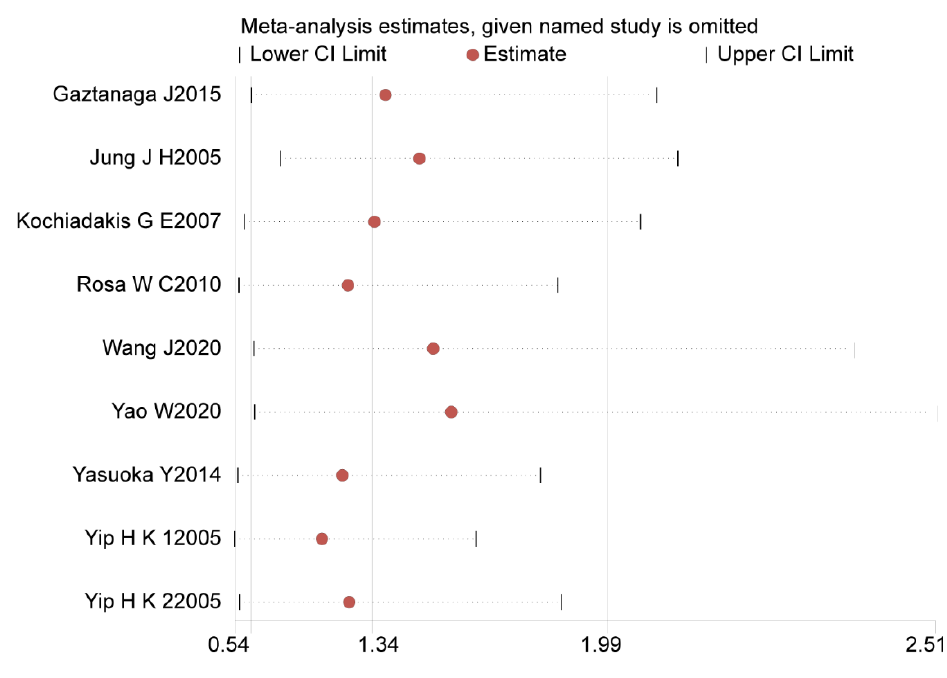
Figure 4. Sensitivity analysis of current meta-analysis [21–29].